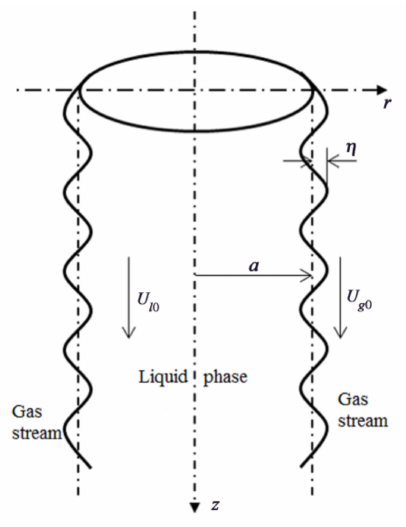
Figure 1. Schematic diagram of a liquid jet and its interface